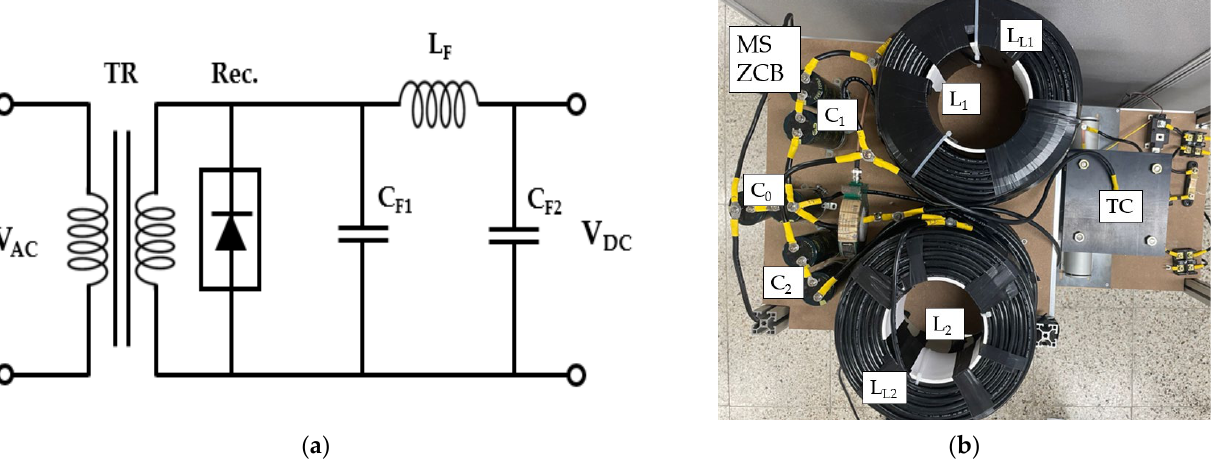
Figure 11. Test setup: ( a ) 550 V DC power supply circuit diagram; ( b ) Z-source circuit breaker setup.